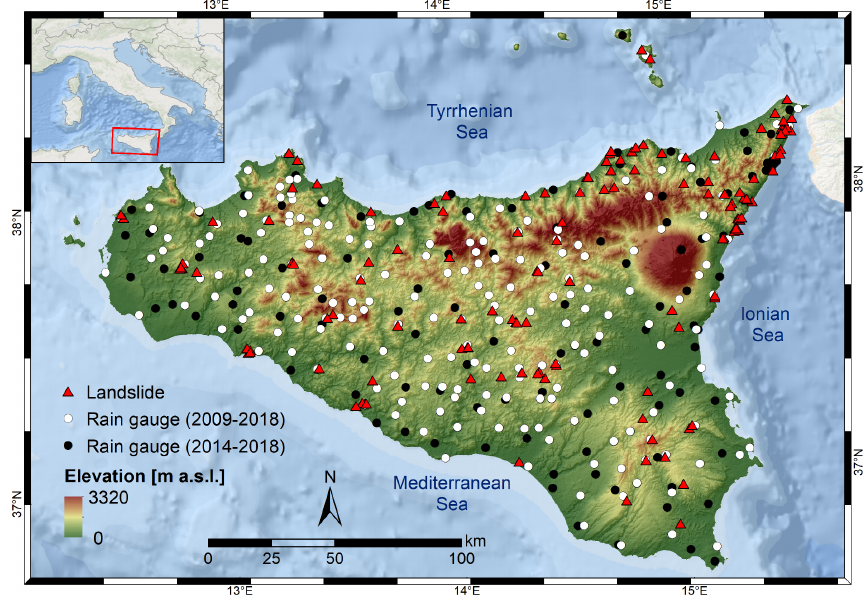
Figure 1. Elevation map showing location of landslides and rain gauges in Sicily considered in this study. The rainfall data set was built by joining data sets managed by different authorities and landslides from the FraneItalia inventory (Calvello and Pecoraro,